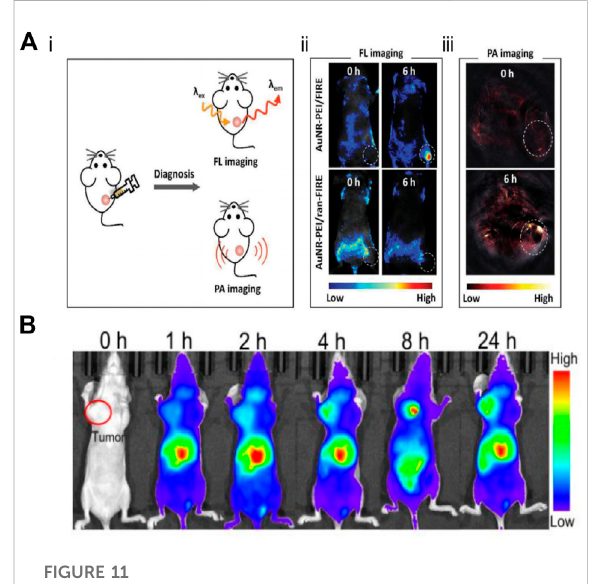
FIGURE 11 Application of fl uorescent nano probe in the detection of tumor related mRNA in vivo (A-i) Mechanistic diagram of fl uorescence (FL) imaging and PA imaging in vivo . (A-ii) Whole- body FL images of MCF-7 tumor-bearing mice injected with AuNR-PEI/FIRE or AuNR-PEI/ran-FIRE. (A-iii) PA image of tumor- bearing mice after injection with AuNR-PEI (Yan et al., 2018). Copyright 2018 Wiley. (B) Apt-DNA-Au nanomachines for in vivo fl uorescence imaging at different times (Yu et al., 2021). Copyright 2020